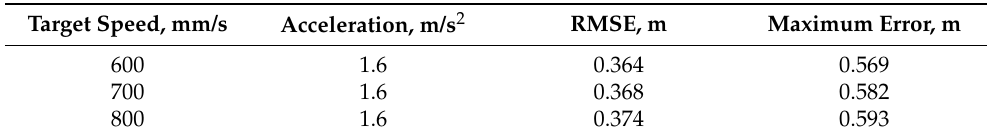
Table 5. The maximum error and RMSE on the z -axis under the same acceleration and different target speeds. Target Speed, mm/s